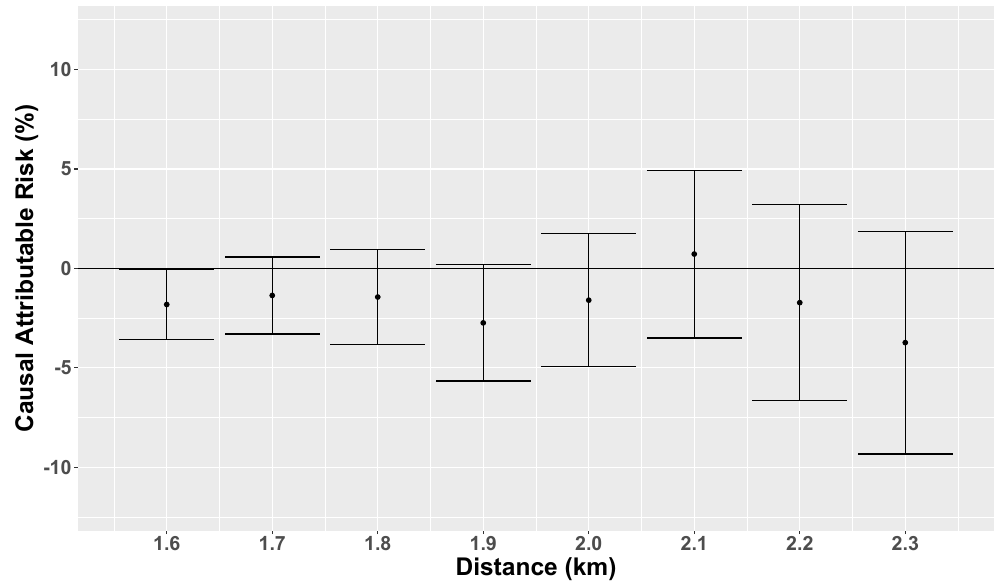
Figure A3. Estimated CAR of asthma or rhinoconjunctivitis in children, expressed as percentage points with whiskers indicate 95% confidence intervals and different distances to the gold mine. Data from children living in a rural mining community in the north of Chile,